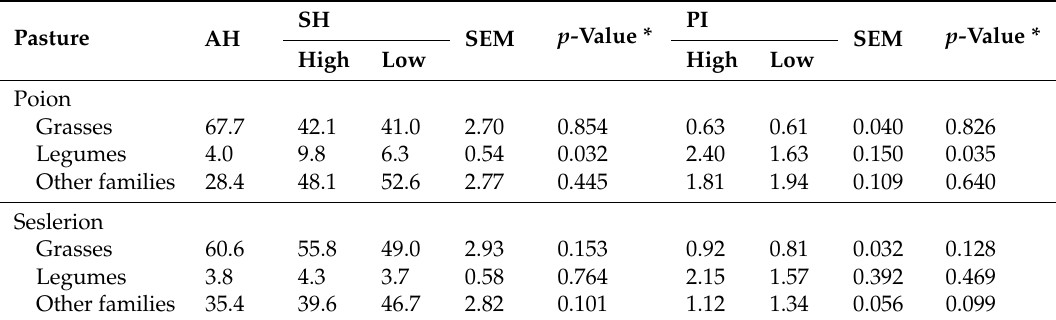
Table 1. Floristic composition (% DM) of available herbage on pastures (AH; n = 6), selected herbage by the cows (SH; n = 48), and palatability index (PI), as affected by different concentrate levels (High and